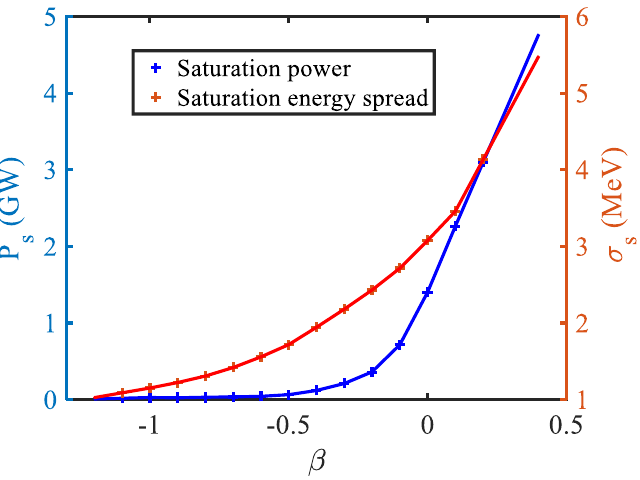
Figure 4. The energy spread at saturation σ s and saturation peak power P s as functions of taper strength β . The “crosses” represent the simulation results and the solid lines are the fitting curves.